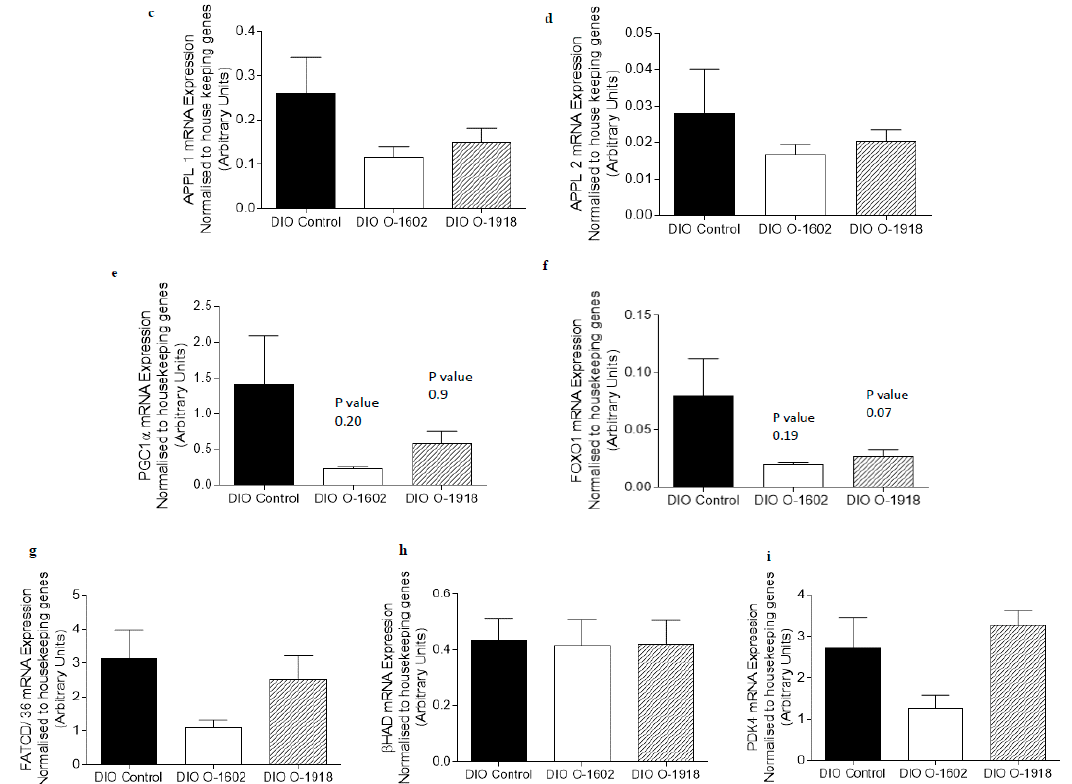
Figure 1. The abundance of mRNA expressed for G Protein-Coupled Receptor 18 and markers involved in adiponectin signalling, fatty acid metabolism and oxidative capacity in red gastrocnemius skeletal muscle obtained from rats fed a high fat diet for 9 weeks to induce obesity. The diet induced obese (DIO) control rats, the DIO O-1602 rats and the DIO O-1918 rats were treated via intraperitoneal injection for a further 6 weeks. mRNA expression was normalised to the average of housekeeping genes cyclophilin and β Actin and grouped data is reported as mean (arbitrary units) ± SEM. Figure 1a The red gastrocnemius treatment groups compared to the white gastrocnemius group (* significance p < 0.05). Figure 1b–i The DIO control group is compared to either the DIO O-1602 group or the DIO O-1918 group. ( a ) G Protein-Coupled Receptor 18 (includes both DIO red and white gastrocnemius); ( b ) Adiponectin Receptor 1 (AdipoR1); ( c ) Adaptor protein containing pleckstrin homology domain, phosphotyrosine binding domain and leucine zipper motif 1 (APPL1); ( d ) Adaptor protein containing pleckstrin homology domain, phosphotyrosine binding domain and leucine zipper motif 2 (APPL2); ( e ) Peroxisome proliferator-activated receptor gamma co-activator 1 alpha (PGC1 α ); ( f ) Forkhead box protein 01 (FOXO1); ( g ) Fatty Acid Translocase/Cluster of Differentiation 36 (FATCD/36); ( h ) beta-hydroxyacyl-CoA dehydrogenase ( β HAD); ( i ) Pyruvate Dehydrogenase Kinase 4 (PDK4).